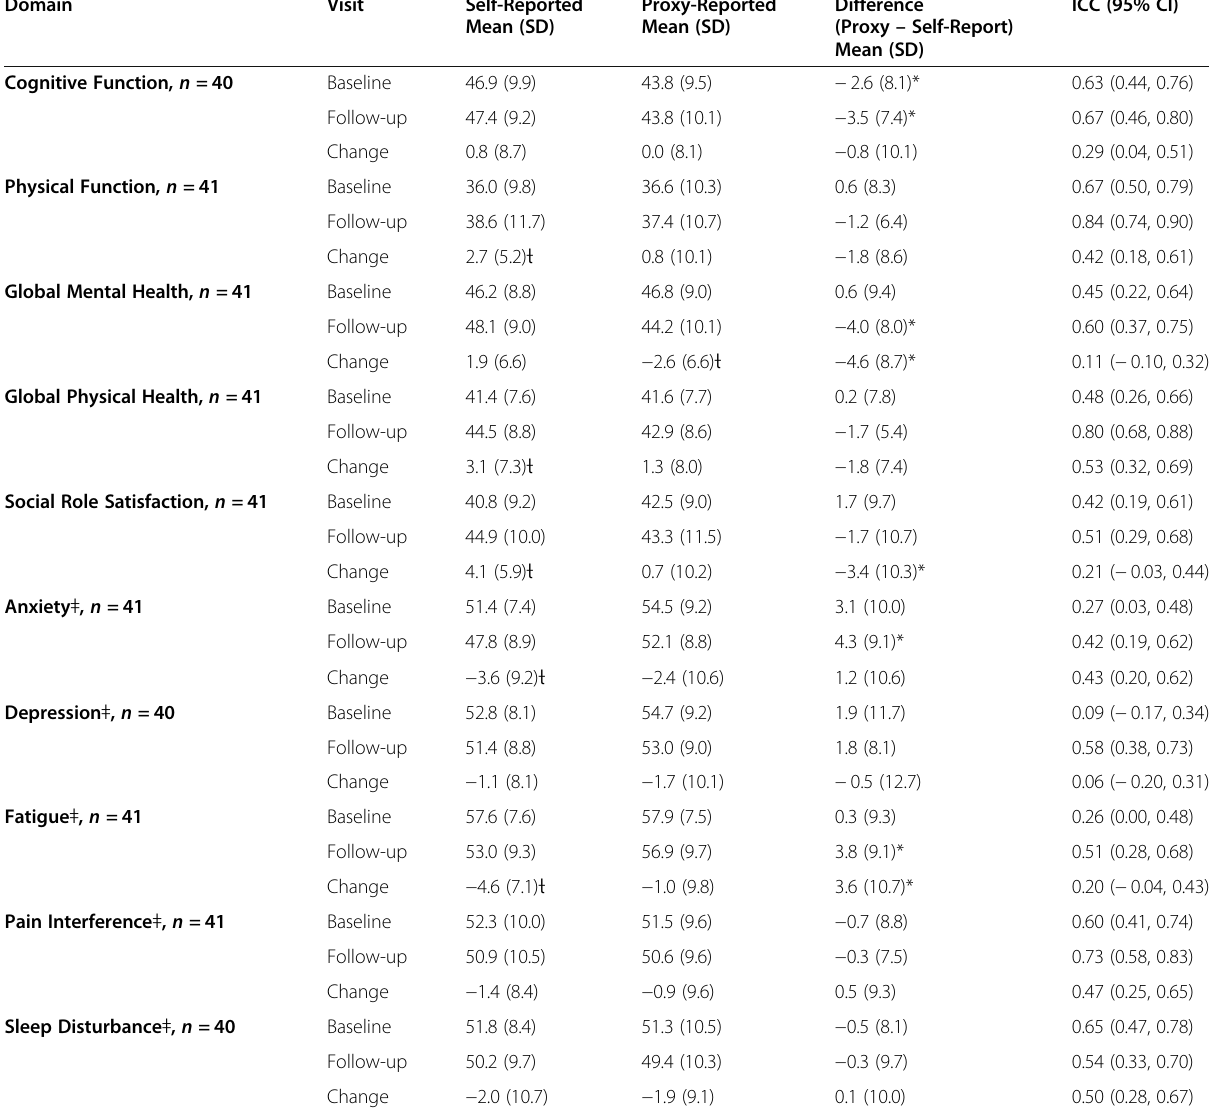
Table 2 Means (standard deviations) of scales for patients and their proxies at baseline, follow-up, and change in score (follow-up – baseline), and intra-class correlation coefficients